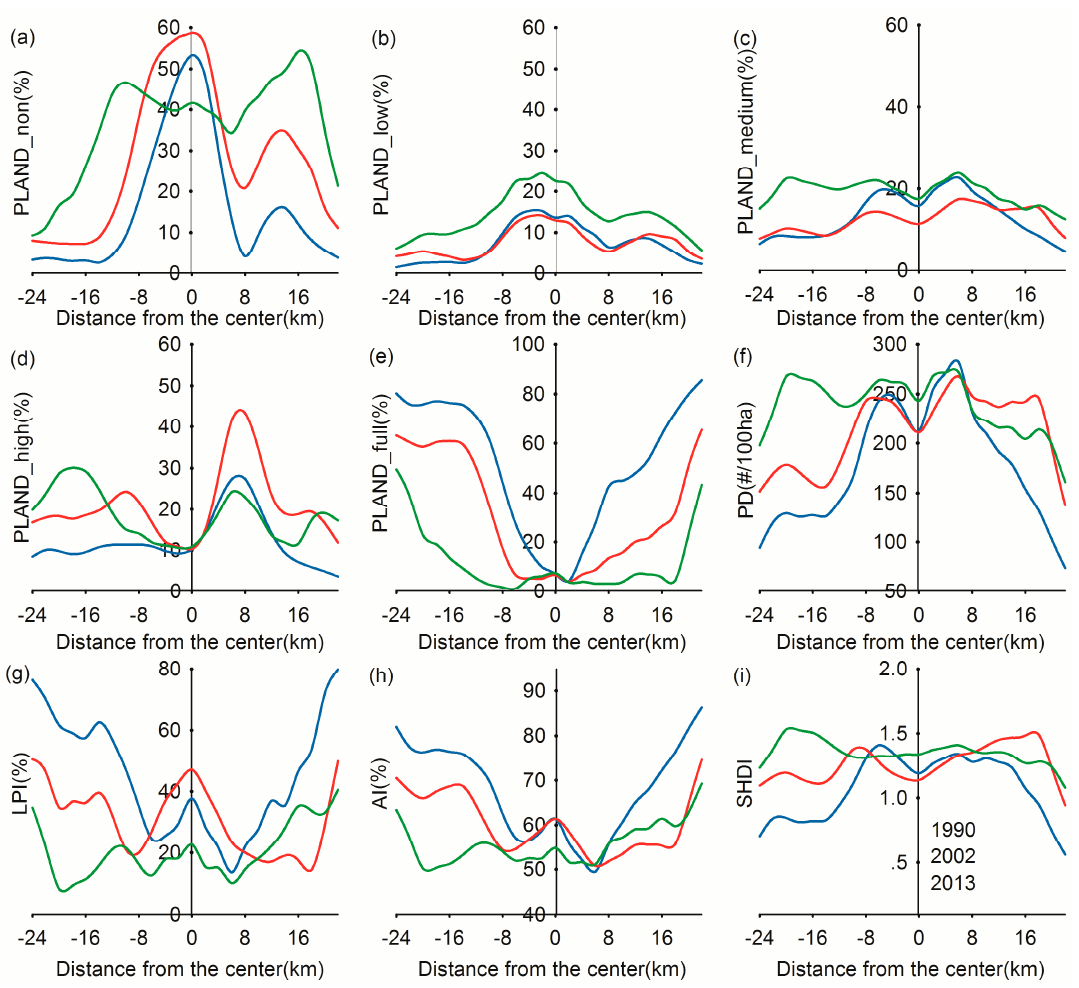
Figure 6. Gradient changes in selected metrics in the north to south transect in 1990, 2002, and 2013: ( a ) percentage of landscape for the non-coverage class; ( b ) percentage of landscape for the low-coverage class; ( c ) percentage of landscape for the medium-coverage class; ( d ) percentage of landscape for the high-coverage class; ( e ) percentage of landscape for the full-coverage class; ( f ) patch density (number of patches/100 ha); ( g ) largest patch index (%); ( h ) aggregation index (%); ( i ) Shannon’s diversity index. The values were obtained from each sampling cell from north to south.